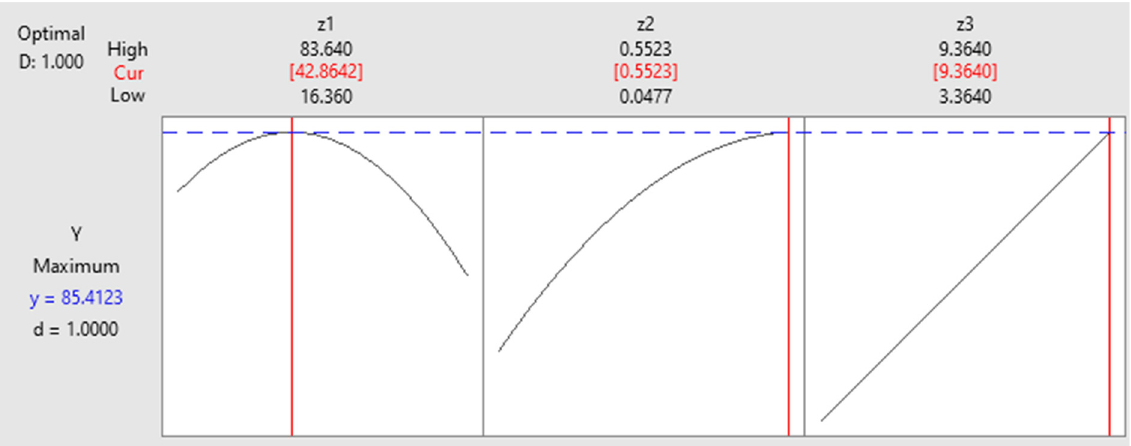
Figure 6. The maximum yield that can be obtained after the optimization of the biosorption process of reactive Brilliant Red HE-3B dye onto a residual S. pastorianus microbial biomass.